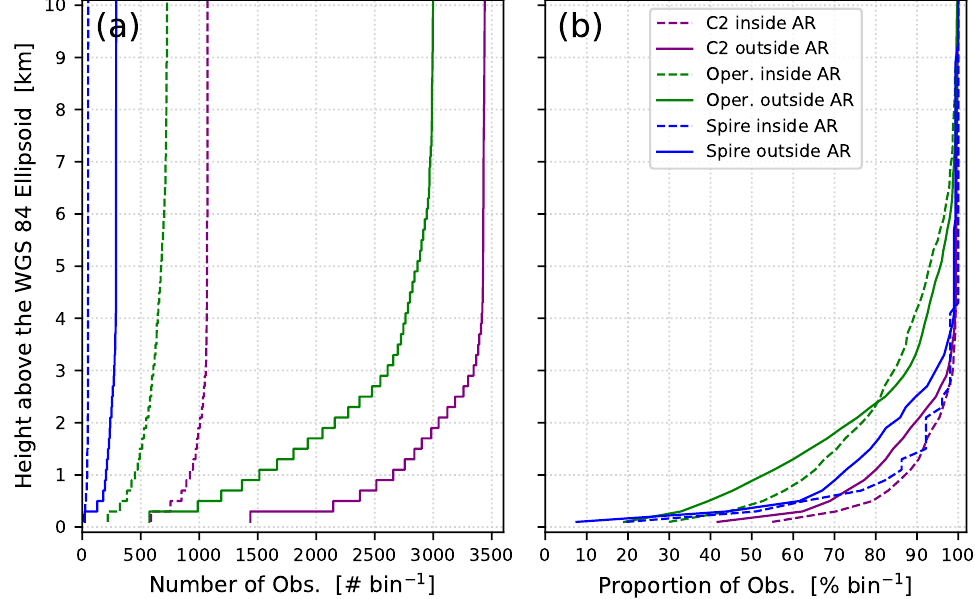
Figure 4. Comparison of ( a ) total count (# bin − 1 ) and ( b ) proportion of the total count (% bin − 1 ) of radio occultation observations in vertical bins (200 m width) for each dataset both within (dashed lines) and outside (solid lines) the atmospheric river. The operational (green lines), COSMIC-2 (purple lines), and Spire (blue lines) datasets are